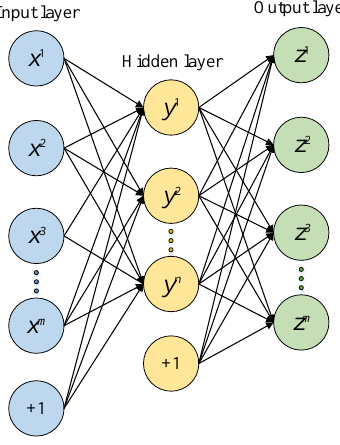
Figure 1. Structure of an auto-encoder neural network (“+1” represents the bias vector). 1 J =